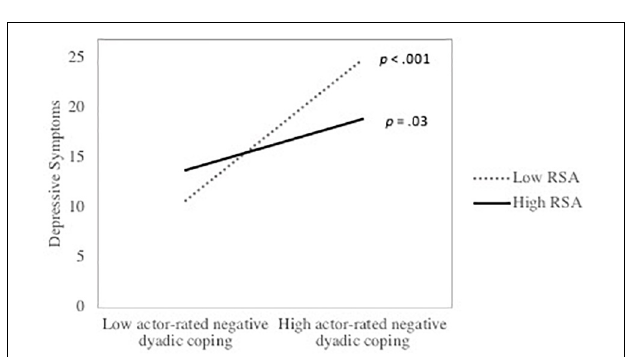
FIGURE 1 | The association between partner-rated delegated DC and depressive symptoms as a function of respiratory sinus arrhythmia (RSA ) among men. p -values represent the significance of the simple slopes at high (1 SD above the mean) and low (1 SD below the mean) of RSA.